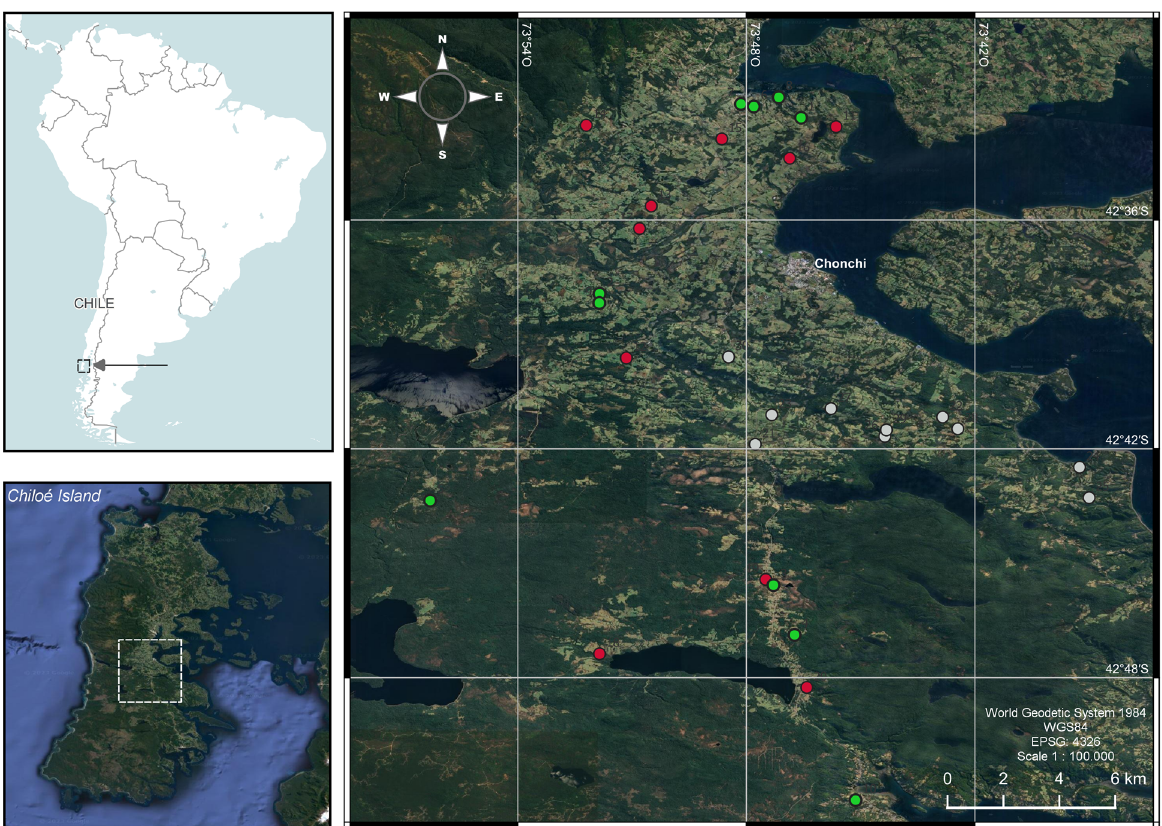
Figure 1. Location of Chiloé archipelago in southern Chile. Farms surveyed in this study are shown as red circles for traditional, grey for conventional and green for agroecological.